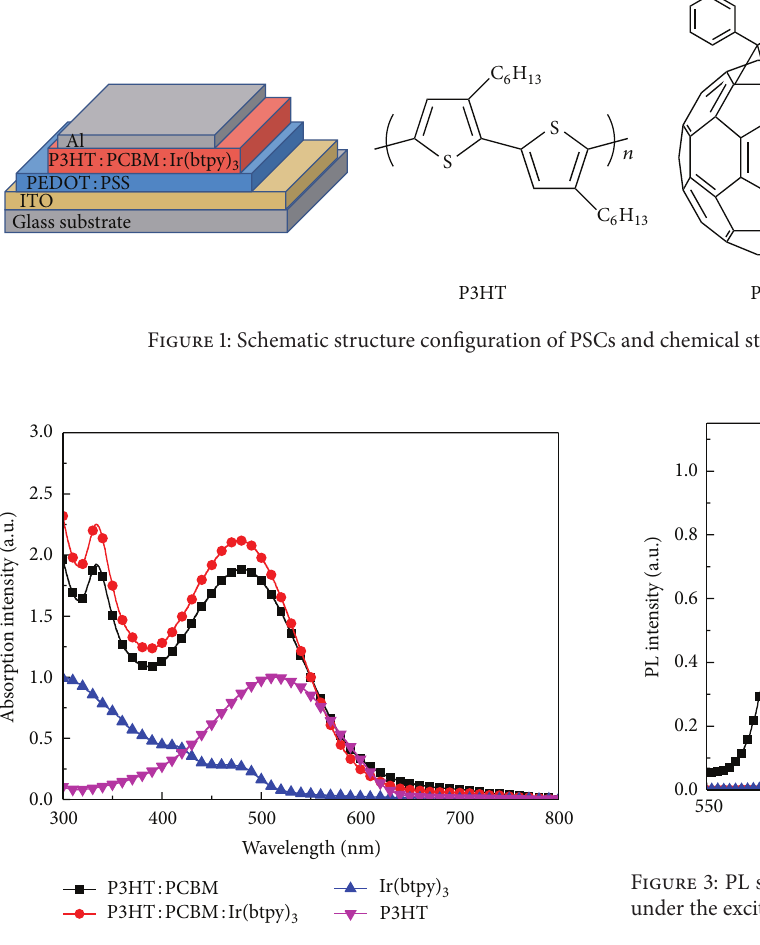
Figure 2: Absorption spectra of neat P3HT, neat Ir(btpy) 3 , P3HT:PCBM, and P3HT:PCBM:Ir(btpy) 3 films.